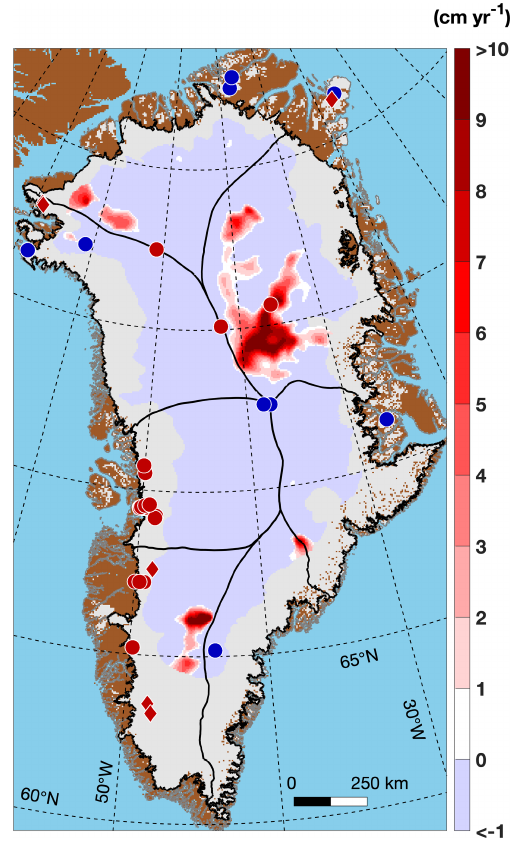
Figure 4. Gridded apparent basal melt rate ( ˙ m ) from 1-D steady- state modeling of Holocene (9–0ka) radiostratigraphy using the Nye + melt model. An ice-thickness-dependent triangular filter has been applied to this dataset (Sect.